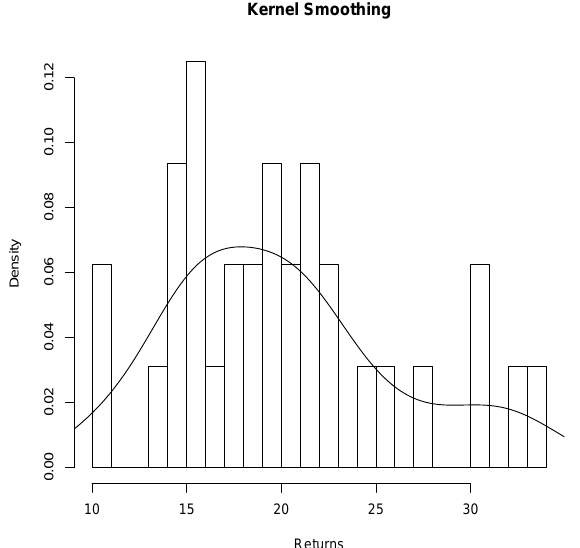
Figure 2. This kernel density estimation illustration shows how a discrete empirical distribution can be transformed into a continuous